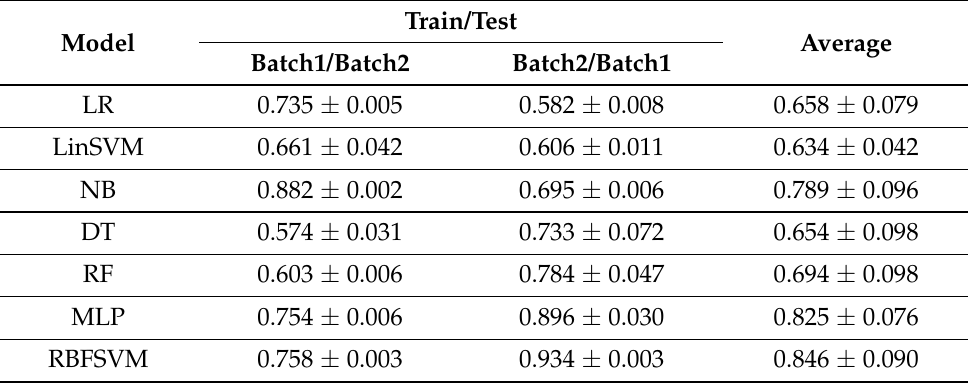
Table 3. Performance comparison between the proposed model and six ML models. The proposed model showed the best independent test balanced accuracy (BACC) results for datasets corresponding to both batches.